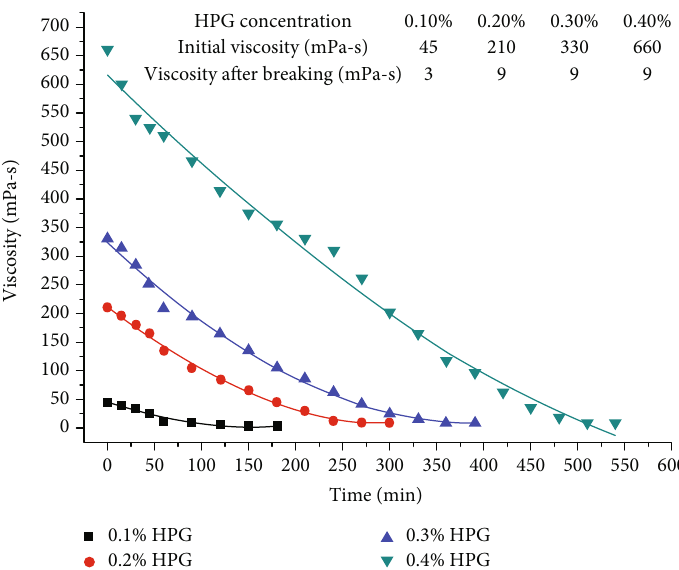
Figure 9: Viscosity changes of four HPG solutions with di ff erent concentrations after breaking.